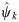
Visualizing and quantifying local changes in orientation of grid patterns.a, b, c, d) From left to right: spike locations; spike locations where each spike is color-coded with its ψ^k score (global Ψ score shown above); autocorrelogram of the firing pattern (ρ score shown above); spike locations where each spike is color coded with its orientation θk (global orientation Θ shown above); four different spatial partitionings of the arena where black lines show partition boundaries and colors of partitions show the average orientation within each partition (mean of θk values) using the orientation color-code. a) Generated perfect grid pattern with orientation of 10 degrees. b) Generated grid pattern with abrupt change in orientation. c) Generated grid pattern with drifting orientation. d) Experimentally recorded grid pattern with drift in orientation. e) Four further experimental examples and the average of their spike-based orientation values in west-east and south-north partitionings. f) Orientations along west-east and south-north in the partitions shown in e. Data kindly provided by Stensola et al. [10].